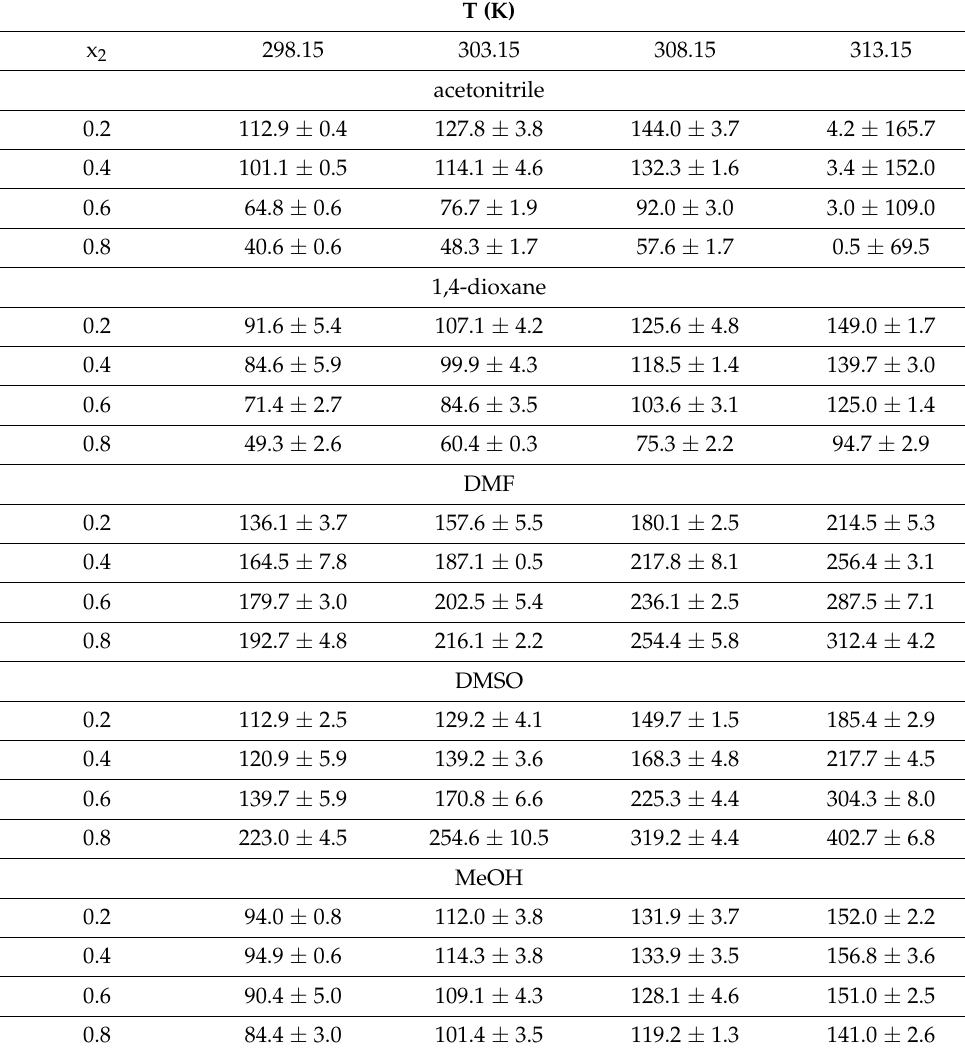
Table 3. Measured values of nicotinamide mole fraction (10 3 ) in a saturated solution of four binary aqueous solutions. x 2 denotes the mole fraction of organic solvent in solute free solutions. T